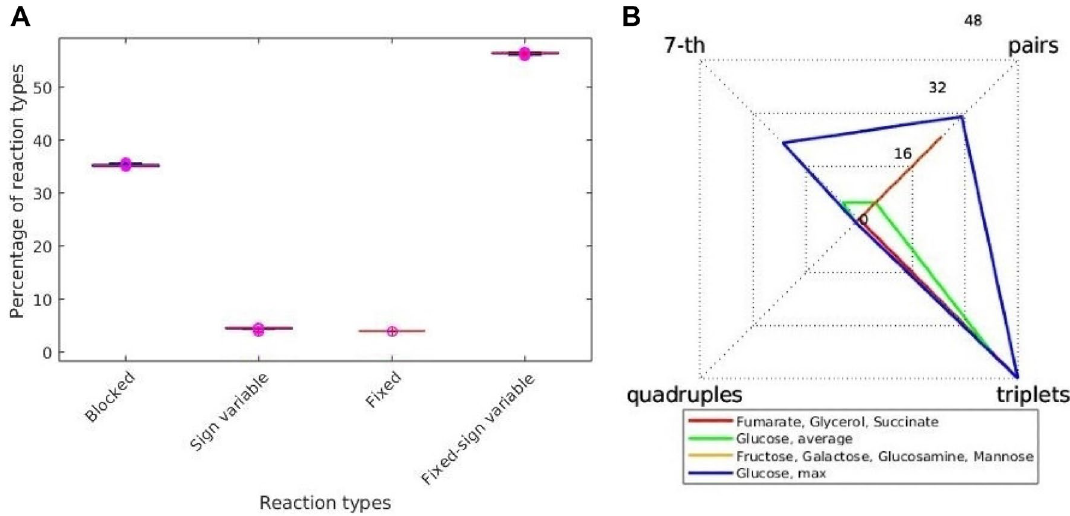
Figure 2. Reaction types based on variability and trade-offs types in E. coli under 26 growth conditions. ( A ) Box plots of the four reaction types across the 26 growth conditions. ( B ) Numbers of trade-offs involving different numbers of reactions, two, three, four and seven, for the 26 growth conditions group in four categories, sharing the same